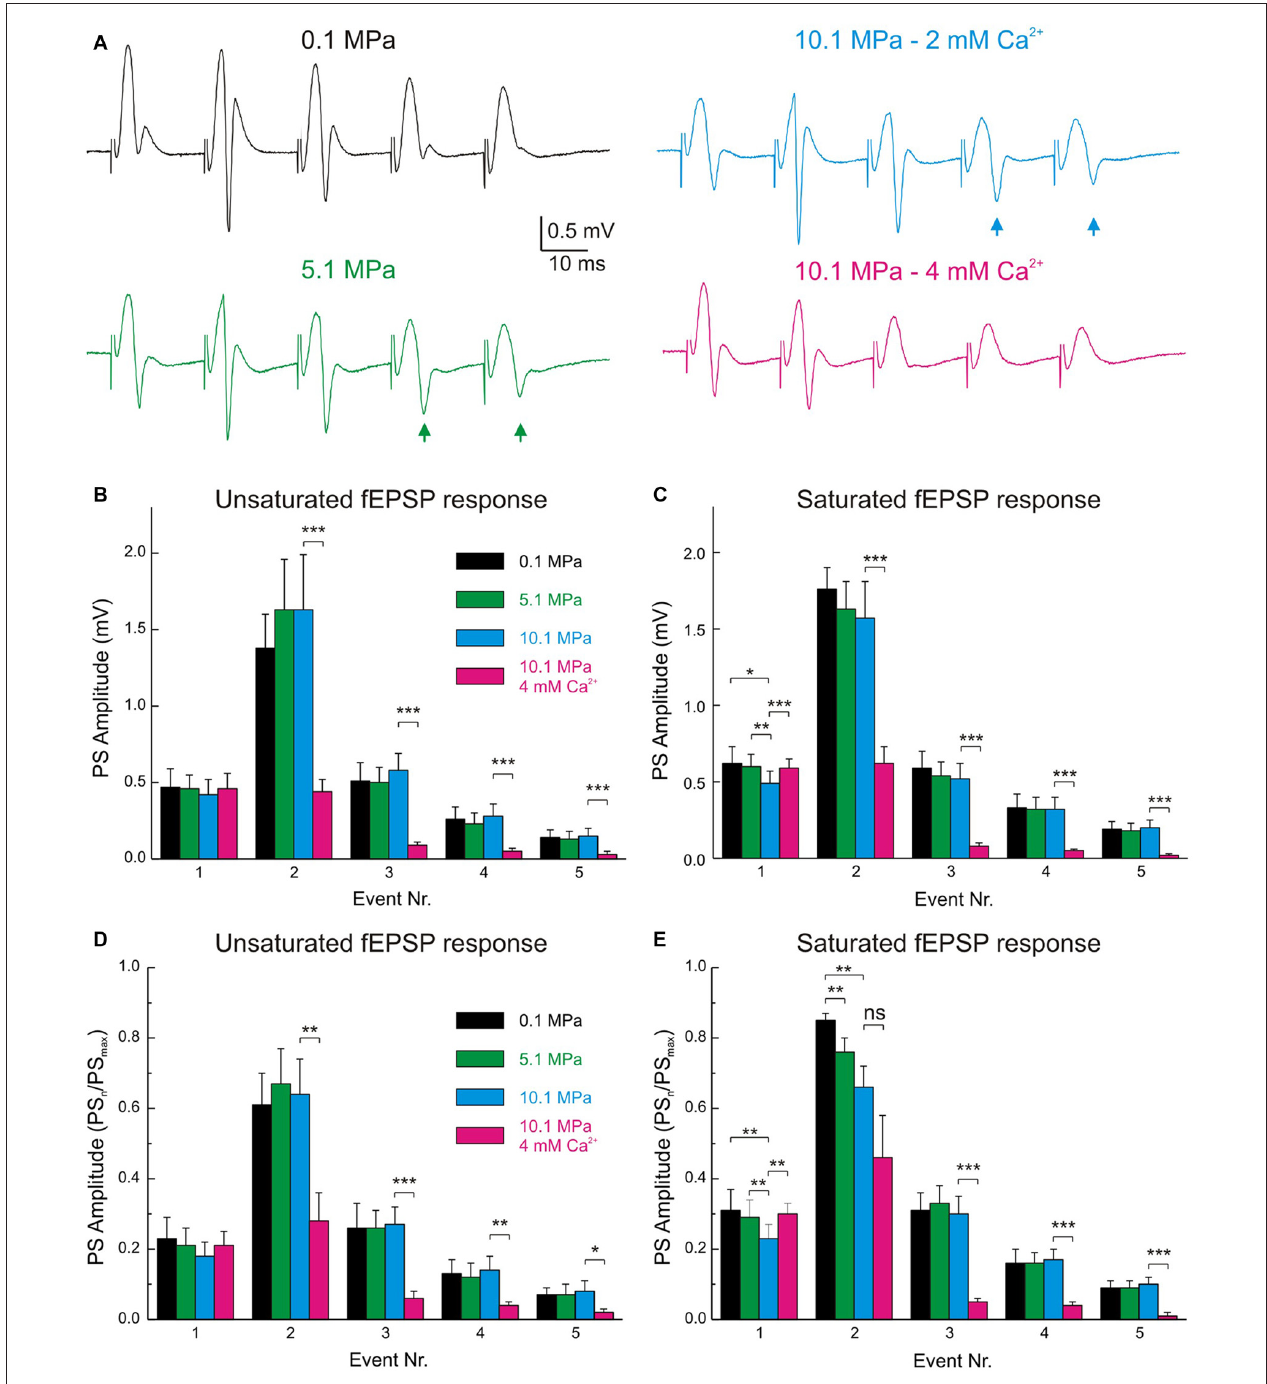
FIGURE 6 | The band-pass properties of the DG are displaced to high-pass by high pressure and to low-pass by raising [Ca 2 + ] o . (A) Electrophysiological recordings of typical fEPSPs and PSs during MPP stimulation at 50 Hz under various pressure and [Ca 2 + ] o conditions. Note the increase in PS 4–5 responses at 5.1 and 10.1 MPa (arrows) and their suppression by increasing [Ca 2 + ] o from 2 to 4 mM at 10.1 MPa. (B) Statistical analysis of the absolute amplitudes of PS 1–5 elicited by unsaturated fEPSPs at 50 Hz under conditions of variable pressure and Ca 2 + . Individual PS n elicited at the different pressures are not significantly different from their corresponding controls ( n = 20). (C) Course of PS amplitude elicited by saturated fEPSPs at 50 Hz under conditions of variable pressure and Ca 2 + . PSs elicited at the different pressures are not significantly different ( n = 25). (D,E) PS n amplitudes normalized to the maximal attainable PS amplitude (PS max ) in trains at 50 Hz in any of the conditions. (D) PS responses to unsaturated E n at 50 Hz ( n = 20). (E) PS elicited by saturated E n at 50 Hz ( n = 25). Events were statistically compared with their respective controls using Students’ t -test ( ∗ p < 0.05; ∗∗ p < 0.01; ∗∗∗ p < 0.001).